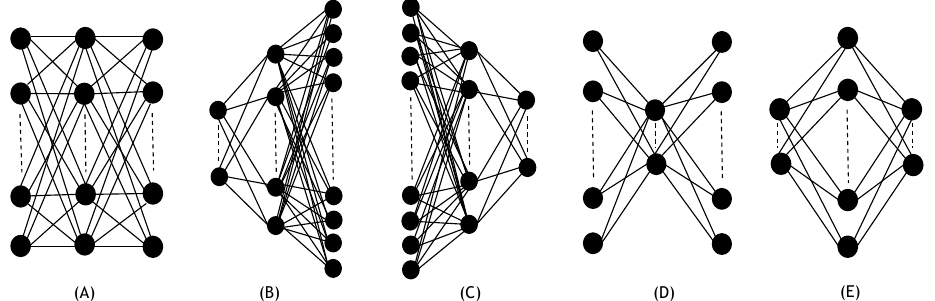
Figure 1. Illustrations in ( A – E ) are the five model architecture shapes used in the analysis. For each architecture shape, number of nodes per hidden layer was varied according to Table 1, in order to change the model